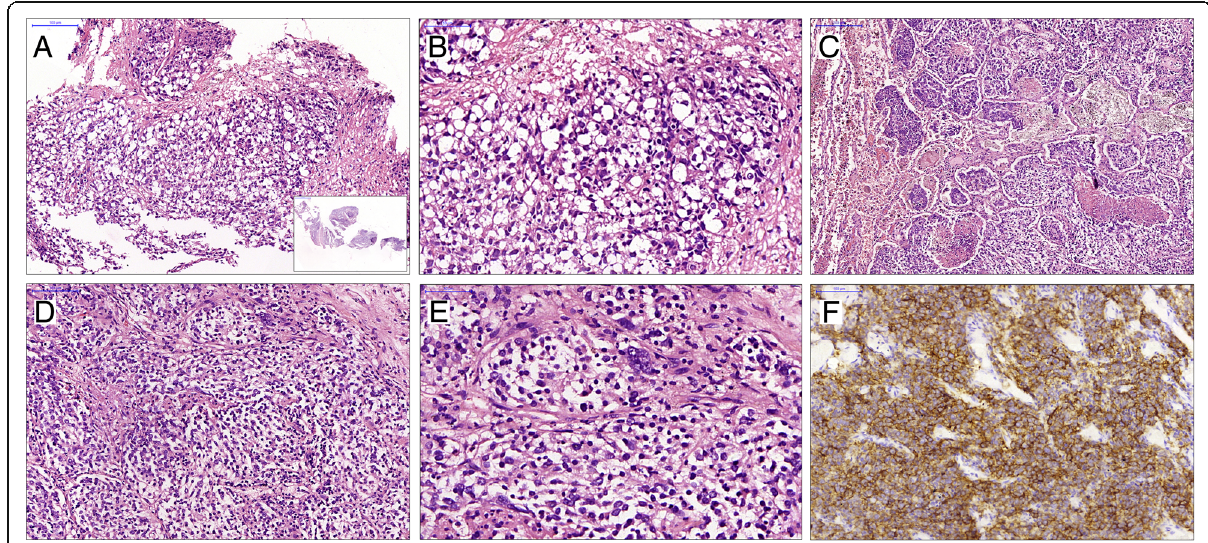
Fig. 3 Case 2: HE staining of needle biopsy specimen reveals that round or ovoid tumor cells with clear cytoplasm are arranged into nests ( a , inset: low-power view of needle biopsy), and high-power view shows the epithelioid cells with moderate to marked cytological atypia ( b ). Resected specimens reveal that epithelioid tumor cells with sheet or nest-like distribution invade into the pulmonary tissues ( c , left area), and multifocal coagulative necroses are seen ( c ), moderate and high-power view of which show the clear epithelioid tumor cells ( d , e ) with CD21 expression ( f ), similarly to those of core needle biopsy